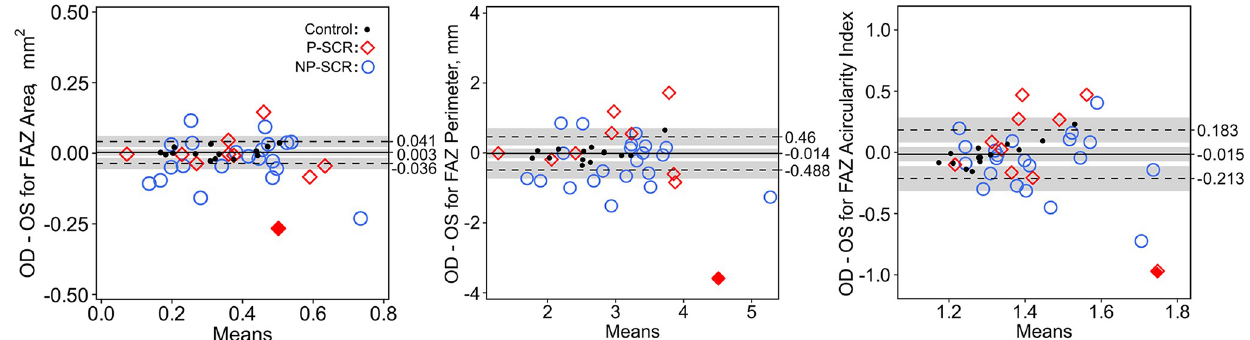
Fig 2. Interocular difference of FAZ metrics characterized by the Bland-Altman analysis. The mean bias (displayed as the solid line) and LOAs (of 2.5% and 97.5% shown in dashed lines) were computed based on unaffected controls, and interocular asymmetry was defined as a value outside these LOAs. The 95% confidence intervals for the mean bias, upper LOA, and lower LOA are shaded in gray. Representative subject labeled with a solid red diamond is displayed in Fig 5. acircularity index (right-eye: 40.0% versus left-eye: 10.0% severity). Unaffected controls dem- onstrated interocular asymmetry in 0% for FAZ area, 7% for FAZ perimeter (right-eye: 7% severity), and 7% of FAZ acircularity index (right-eye: 7% severity).